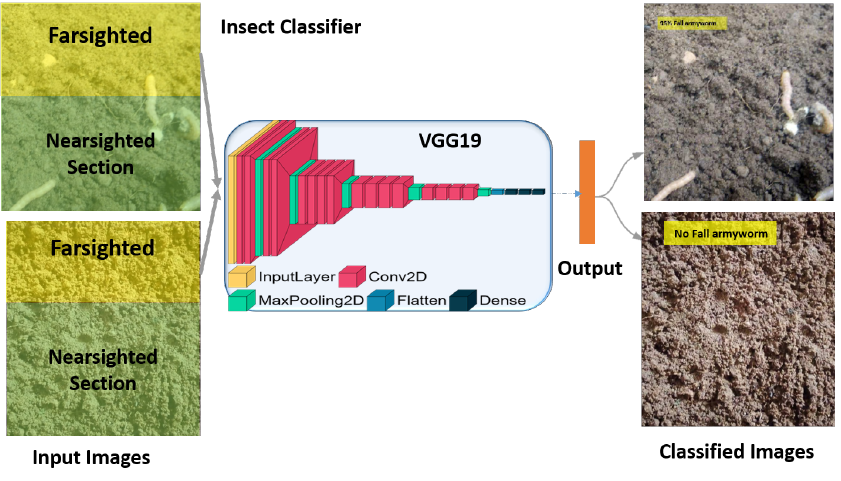
Figure 5. Network architecture of deep-learning insect pest classifier, with emphasis on VGG19 as the most accurate base network adopted for the farsighted section of the proposed recognition